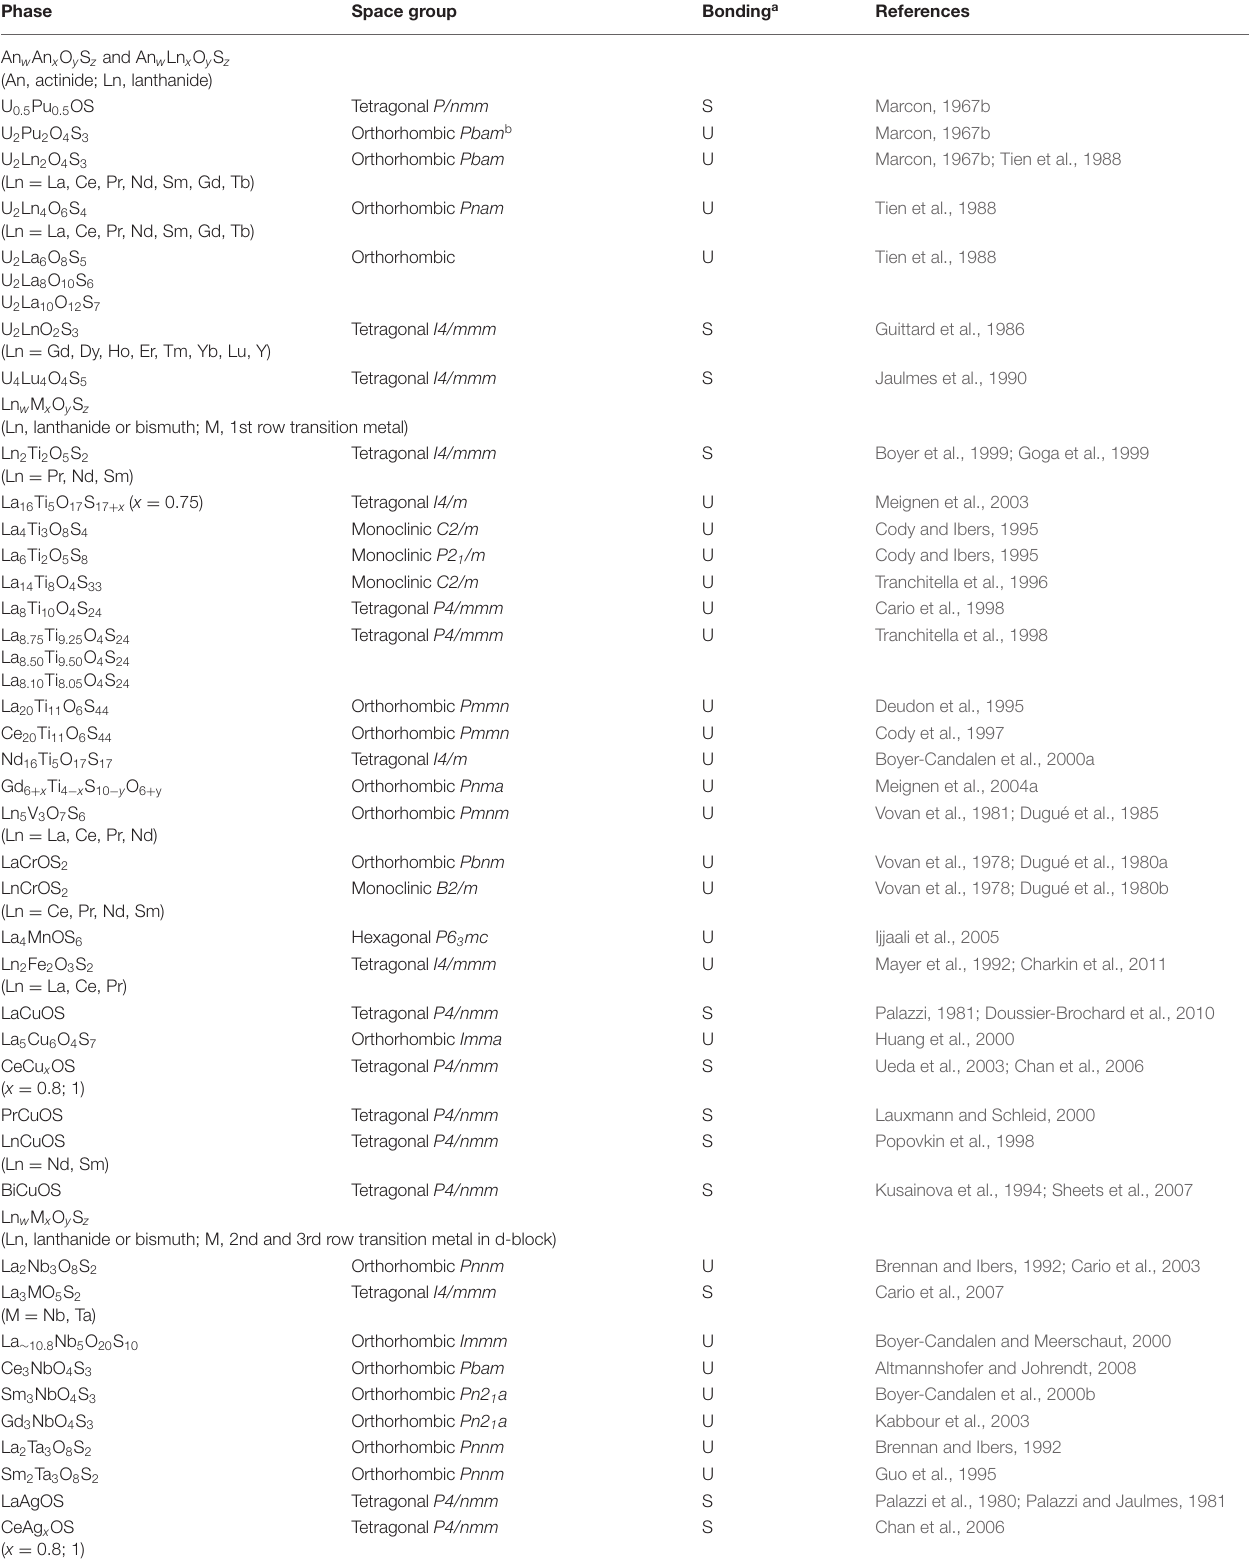
TABLE 1 | Quaternary oxysulfides M 1 w M 2 x O y S z .